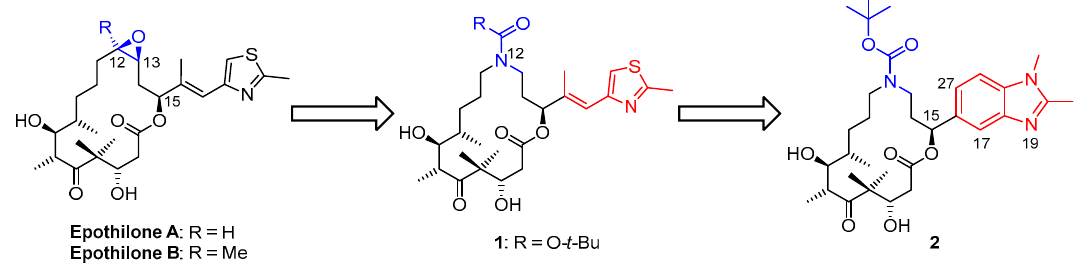
Figure 1. Molecular structures of epothilones A and B and their evolution into azathilones.